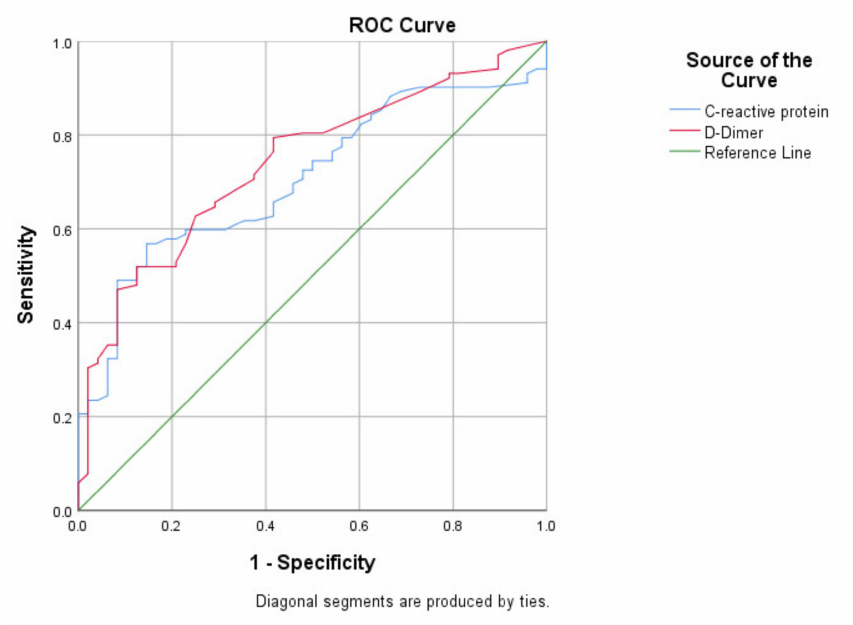
Figure 1. ROC analysis for specified